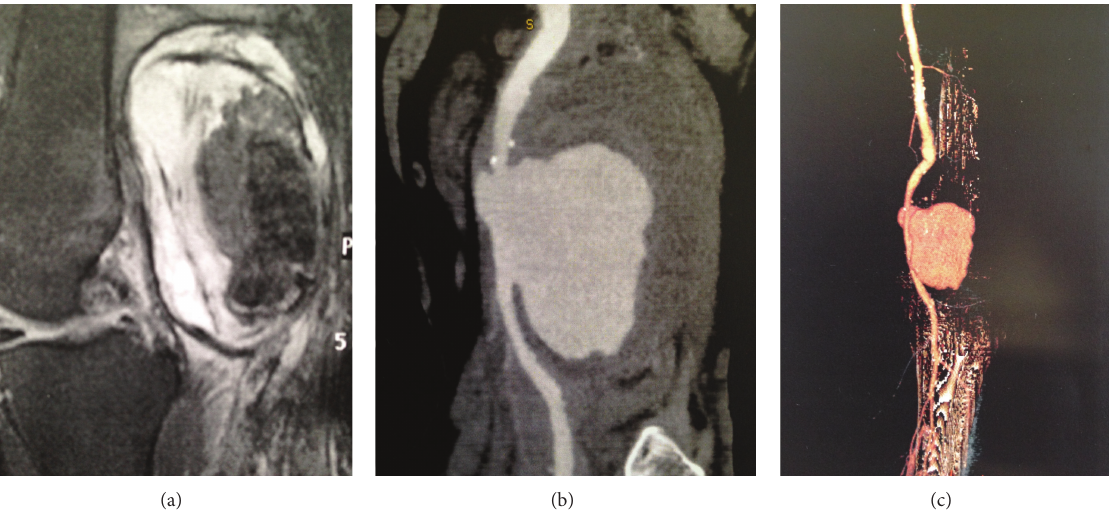
Figure1:(a)Magneticresonanceimaging(MRI)showingthehugepoplitealarteryaneurysm.(b)Computedtomographyangiography(CTA) depicting the huge aneurysm with significant thrombus inside the aneurysm sac. (c) 3D reconstruction of CTA showing the aneurysm with the inflow and outflow vessels.